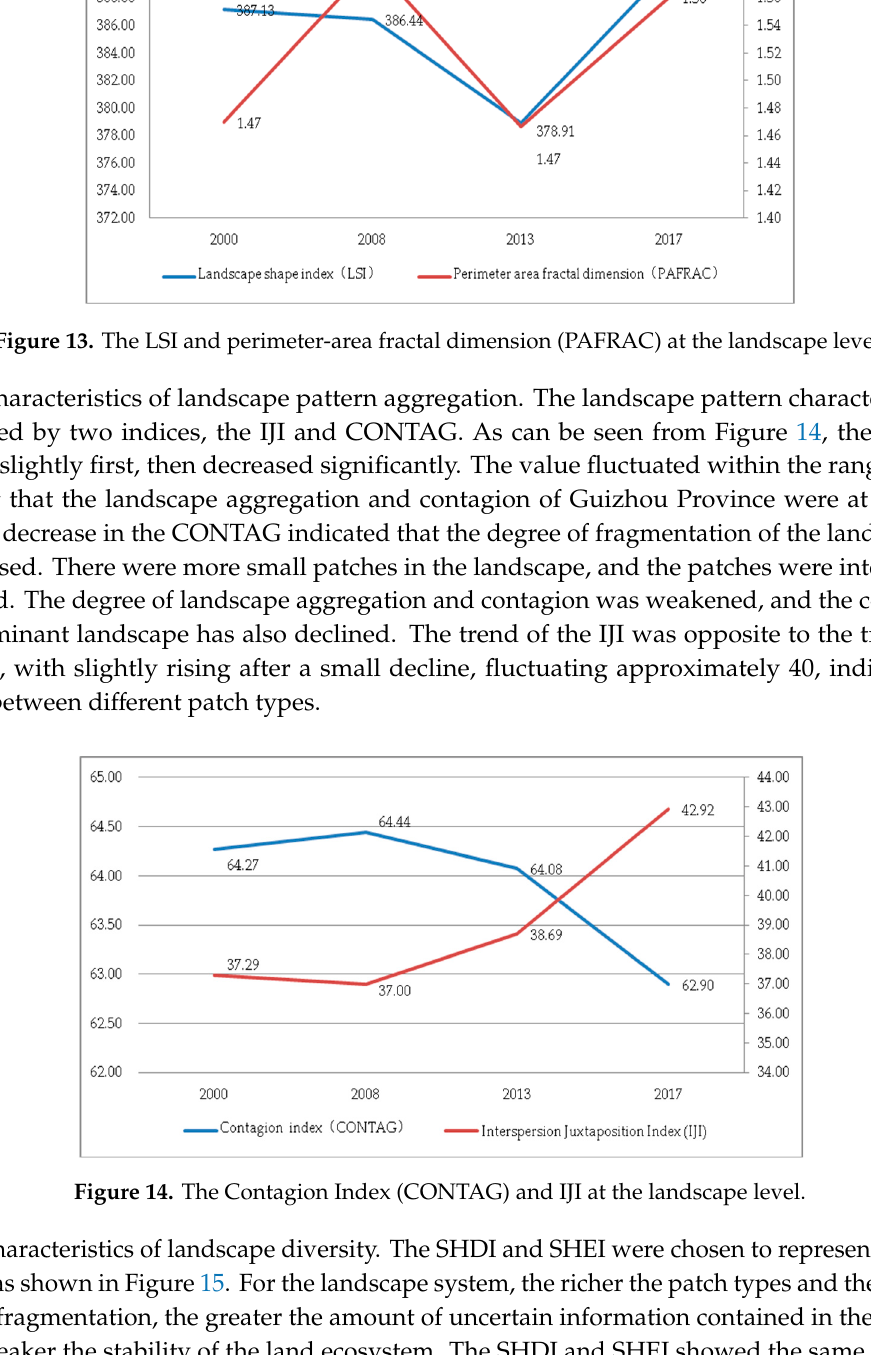
Figure 12. The LPI at the landscape level.